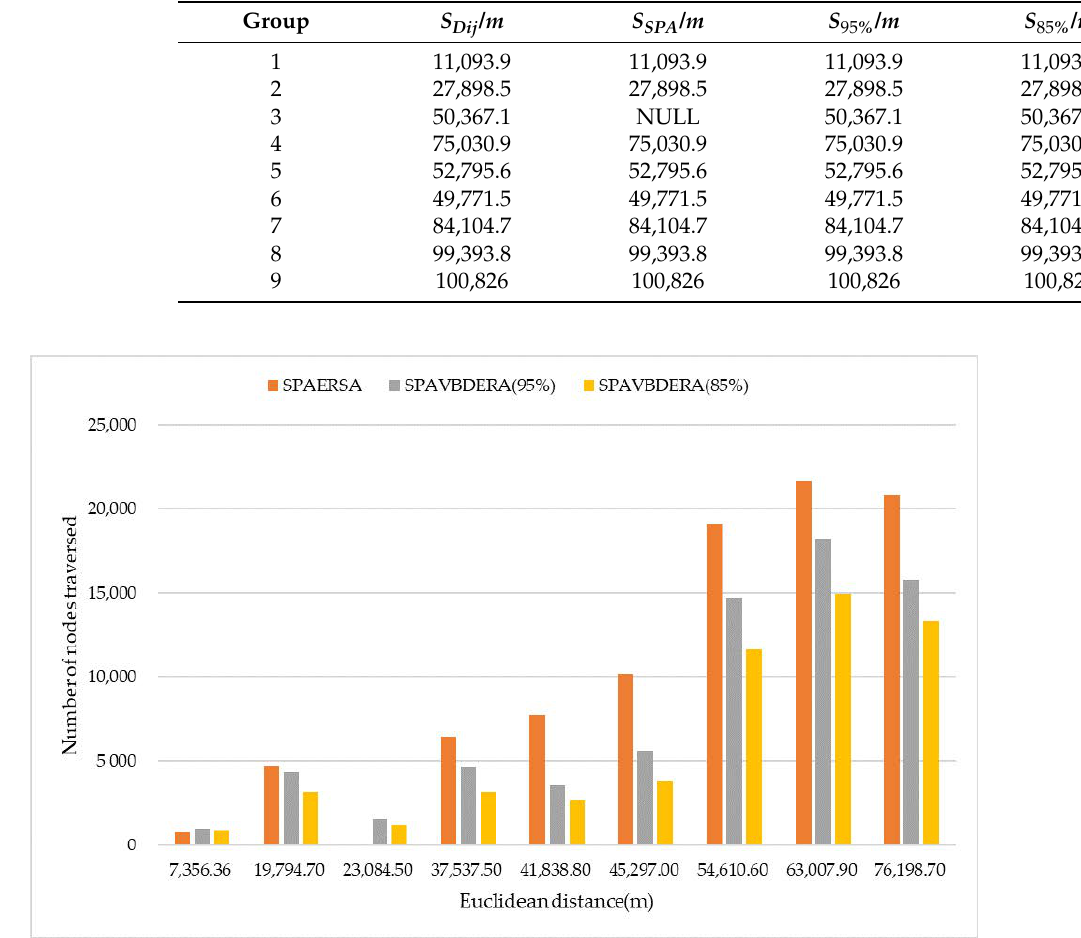
Figure 9. The number of nodes traversed by the three algorithms under different Euclidean distances.